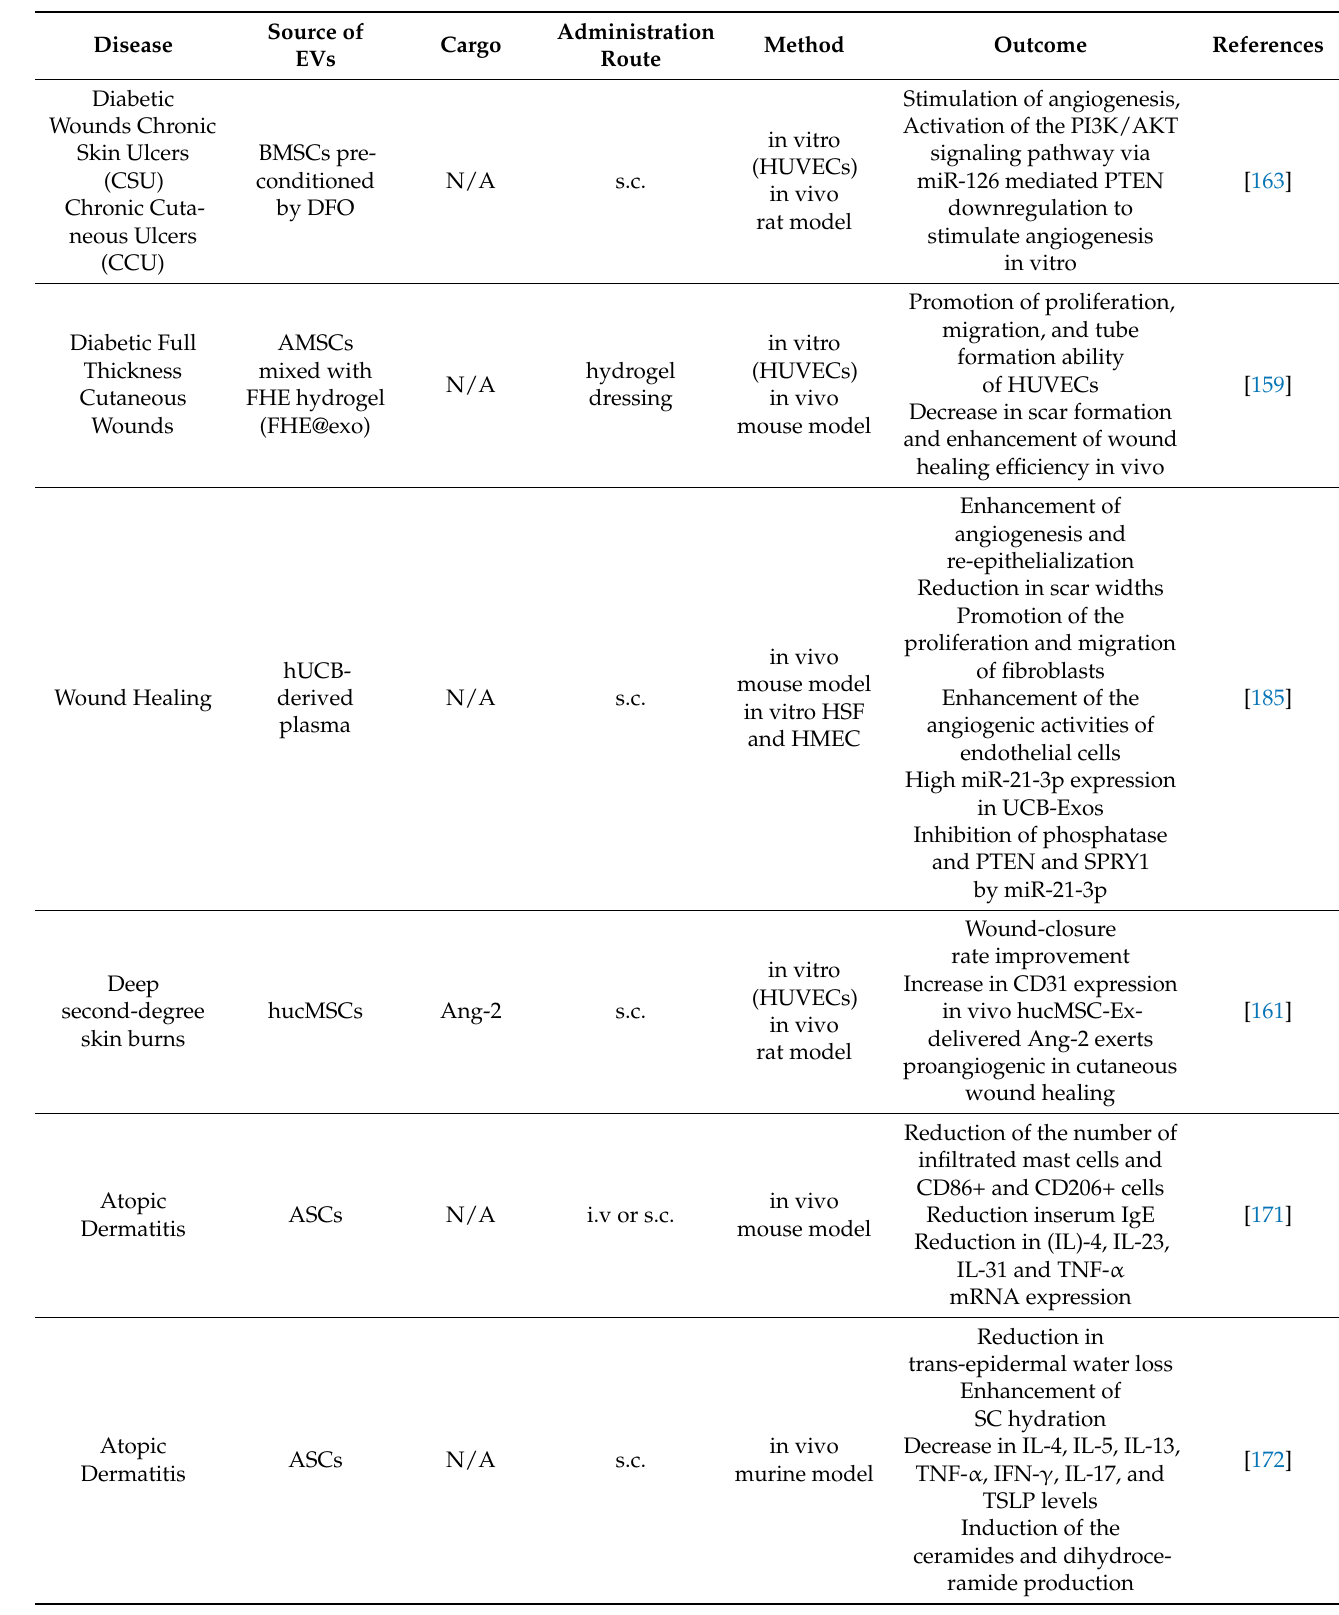
Table 4. Selected EVs in dermatology and aesthetic